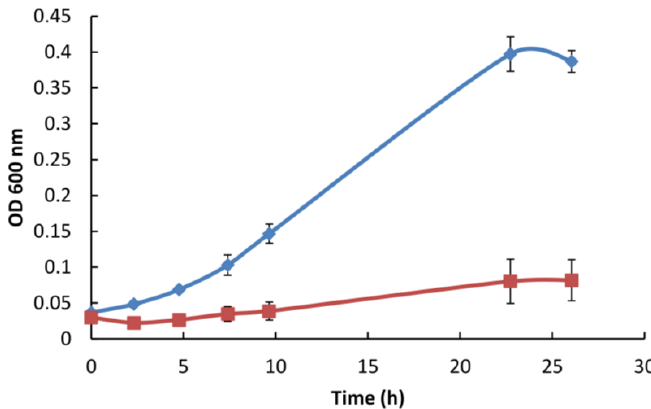
Figure 4. Full-length Gp047 added exogenously to C. jejuni 11168 broth cultures inhibits cell growth. GST-Gp047 (75 µg/mL final concentration) was added to cells suspended in MH broth and grown at